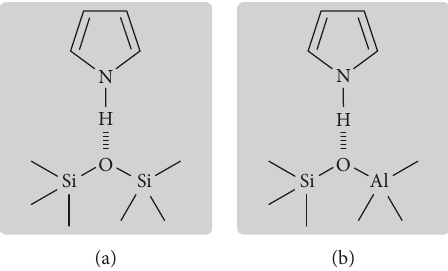
Figure 2: Possible hydrogen bonding interactions between pyrrole and Saudi grey kaolin: (a) predominant silica surface; (b) mixed silica/alumina surface.